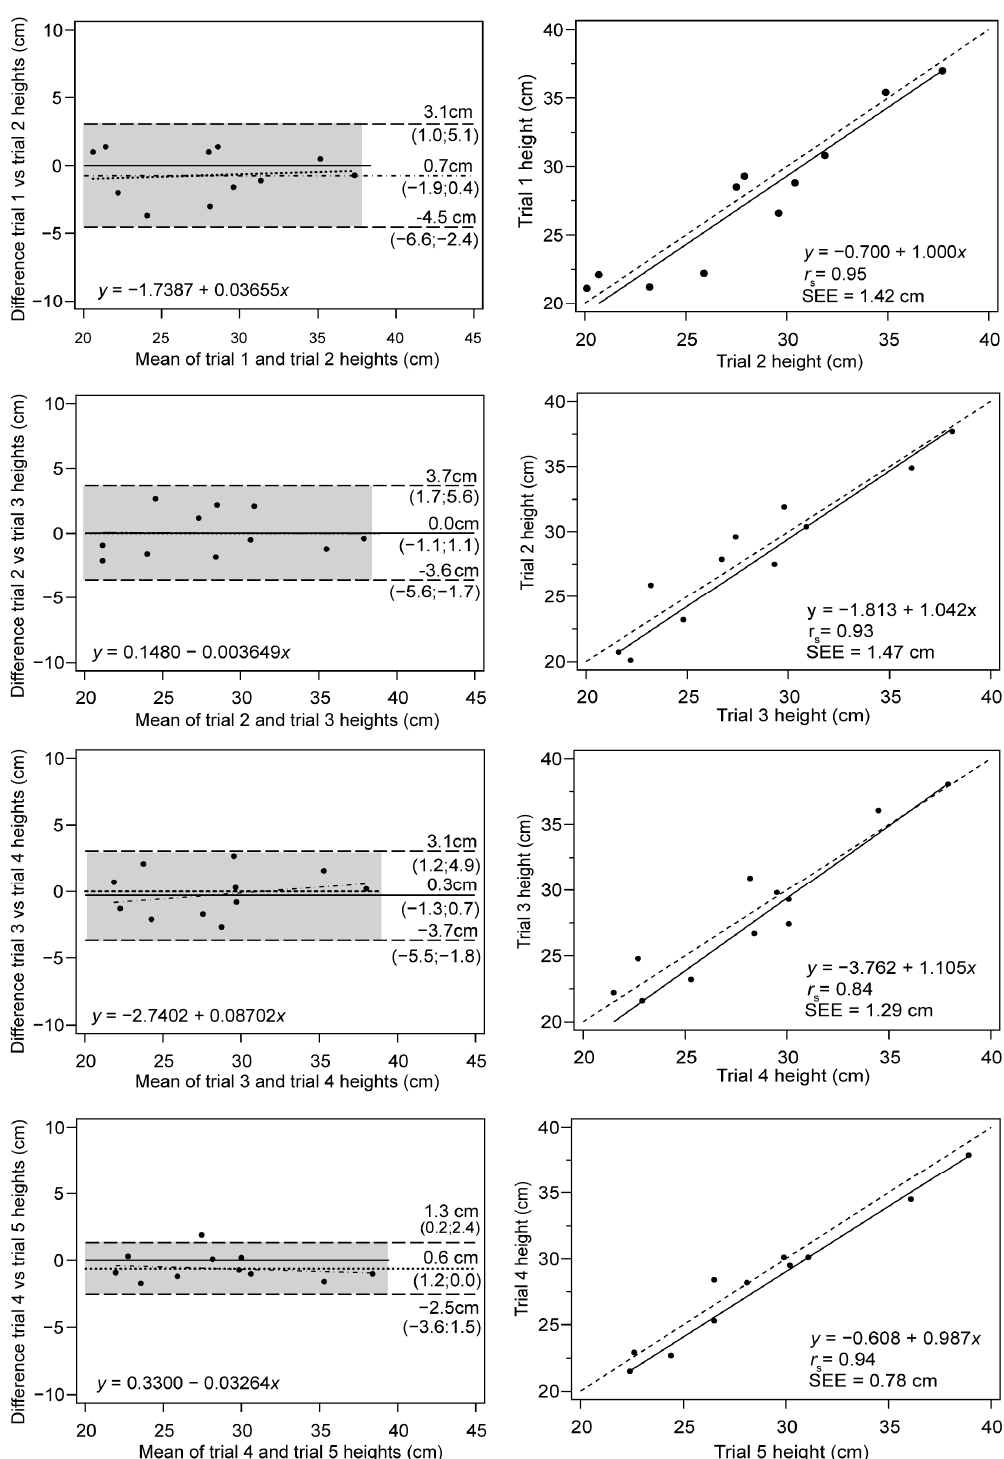
Figure 5. Within-session consistency for consecutive trials. ( Left ) Bland–Altman plots for consecutive pairs of jumps between ADR and MoCAP. The pointed line: the mean of the differences (systematic error); dashed lines: the upper and lower LoA (random error); the continuous line: the ideal agreement; the dashed and dotted line: the regression line of the differences (a proportional error); Mean: mean of the differences; SD: standard deviation; dashed area: confidence intervals for 95% of the LoAs and mean. ( Right ) Passing-Bablock regression for consecutive trials. The dotted line: linear regression; SEE: standard error of the